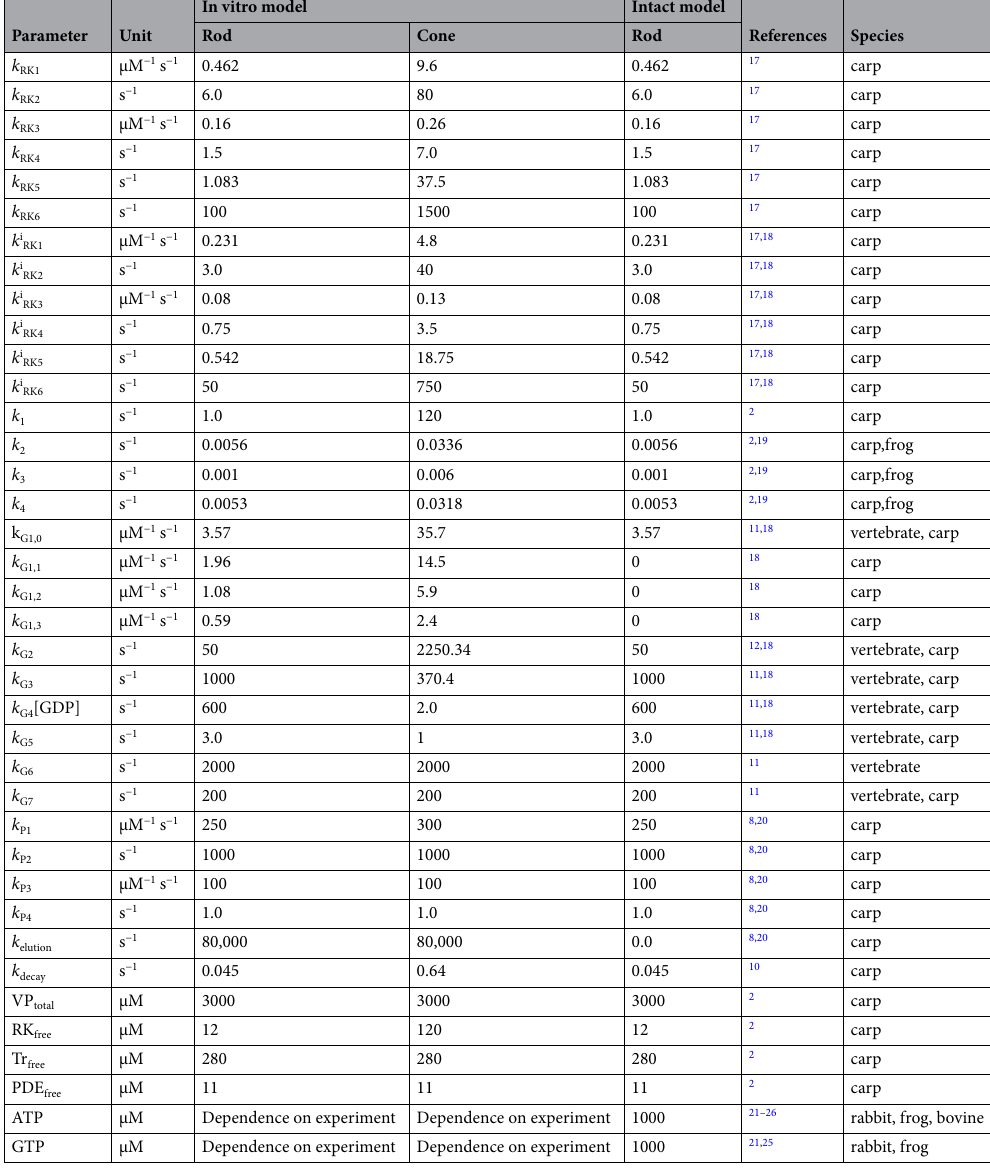
Table 3. Parameters in the current